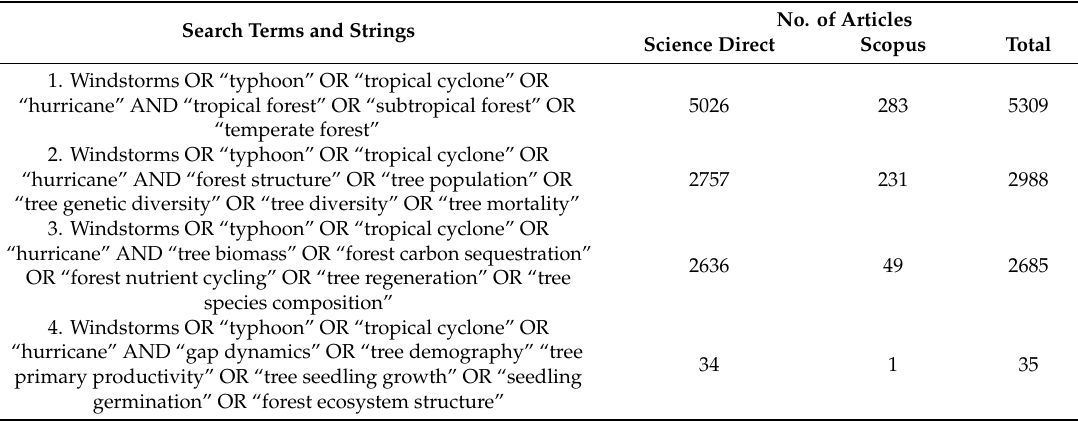
Table 1. The search terms and Boolean strings used in the systematic literature review using articles’ title, abstract, and keywords in Science Direct and Scopus